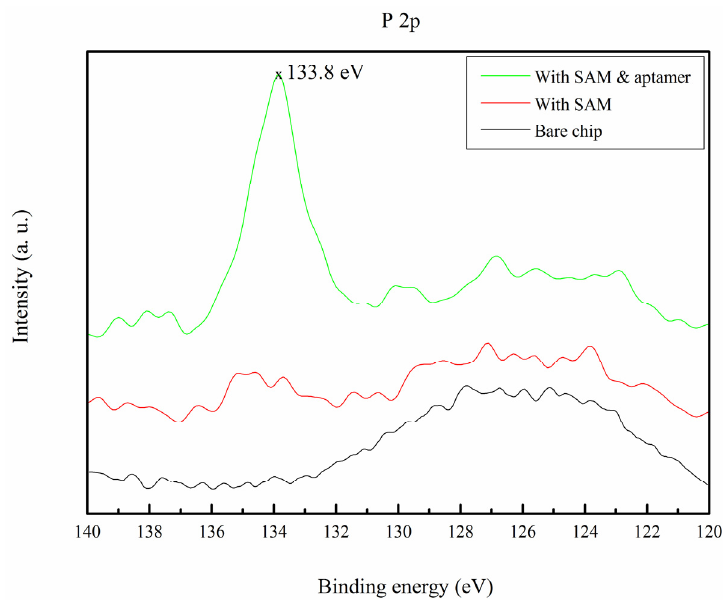
Figure 4. Bonding energy of bare fused silica (black), SAM (red), and chip with immobilized aptamer (green). The peak of the aptamer was at 133.8 eV, which is 6 times higher than that of other